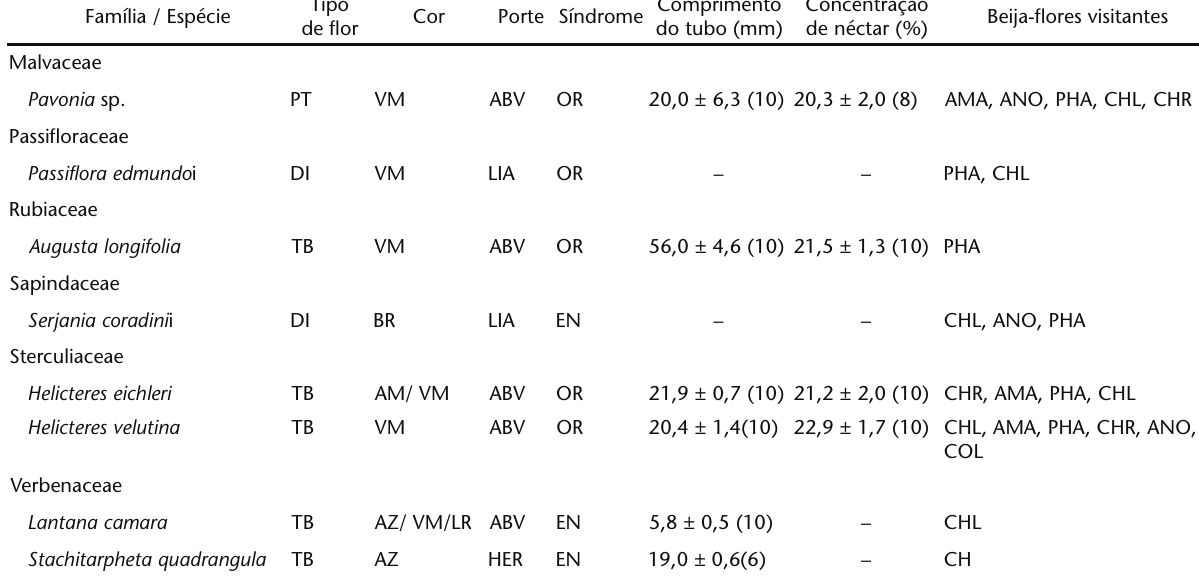
Tabela III. Matriz das interações agressivas registradas entre beija-flores (Aves: Trochilidae) em uma área de caatinga, no município de Mucugê, Chapada Diamantina, Bahia, no período de outubro de 2005 a agosto de 2007. Para cada espécie foi feita a somatória